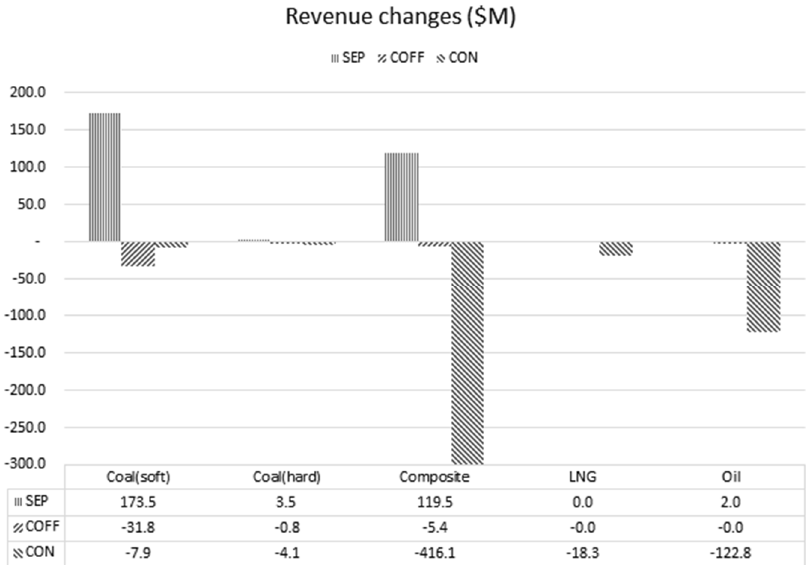
Figure 7. Estimated revenue change by fuel